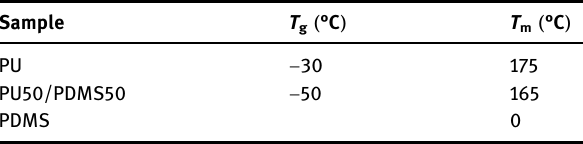
Table 4: The glass transition temperature ( T g ) and melting tem - perature ( T m ) of PU – PDMS polymer from DSC analysis